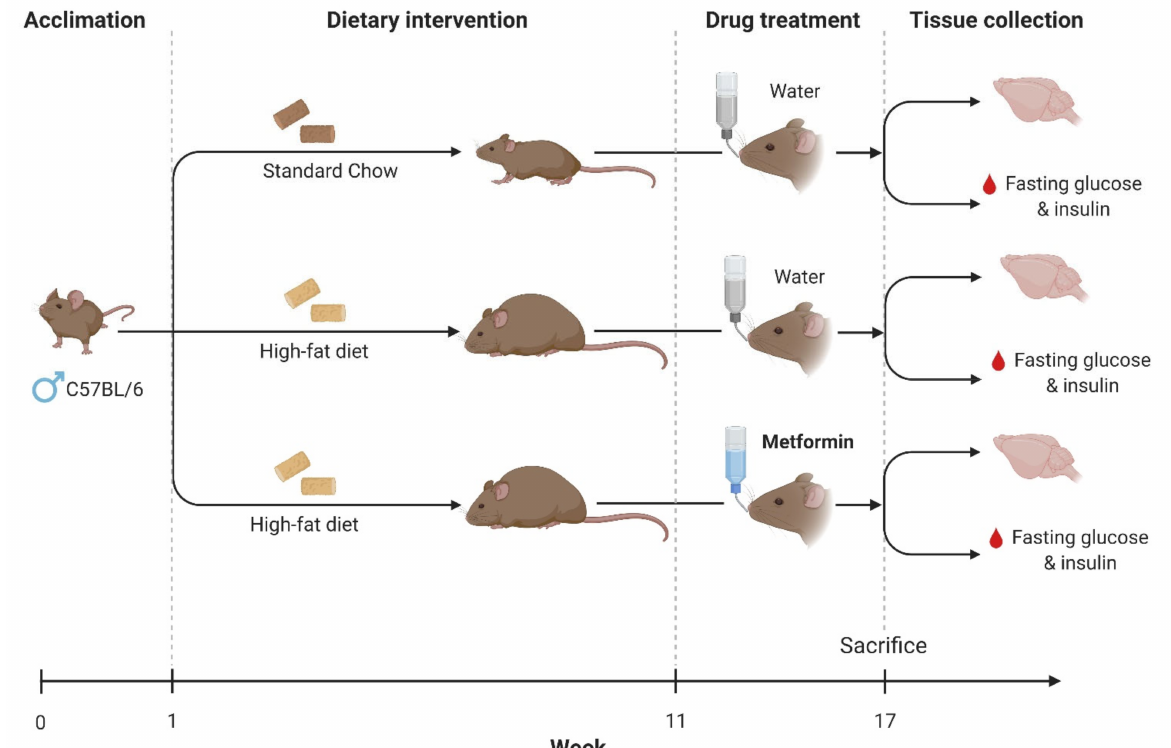
Figure 11. Experimental design. Schematic diagram depicting the experimental design consisting of a dietary intervention to induce obesity and insulin resistance (high-fat diet) and pharmacological treatment (metformin) to ameliorate brain inflammation. At the end of the experimental protocol, brains and blood samples were collected for downstream